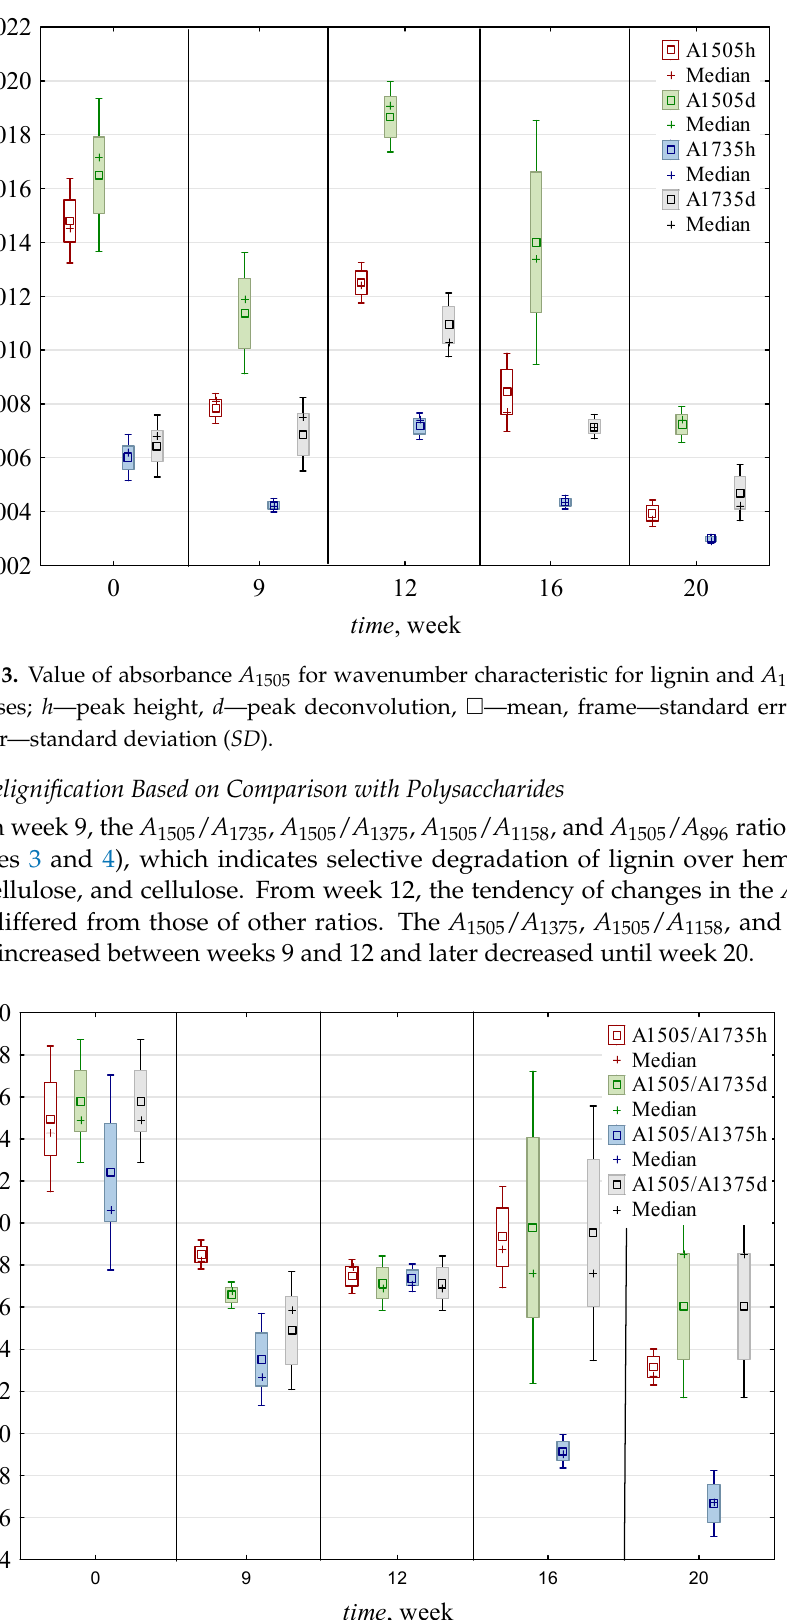
Figure 2. FTIR spectra for selected particleboard samples after 0, 9, 12, 16, and 20 weeks pretreat- ment with P. ostreatus.